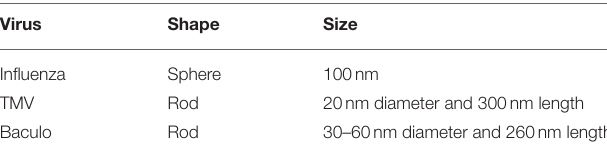
TABLE 1 | Dimensions of viruses used in this